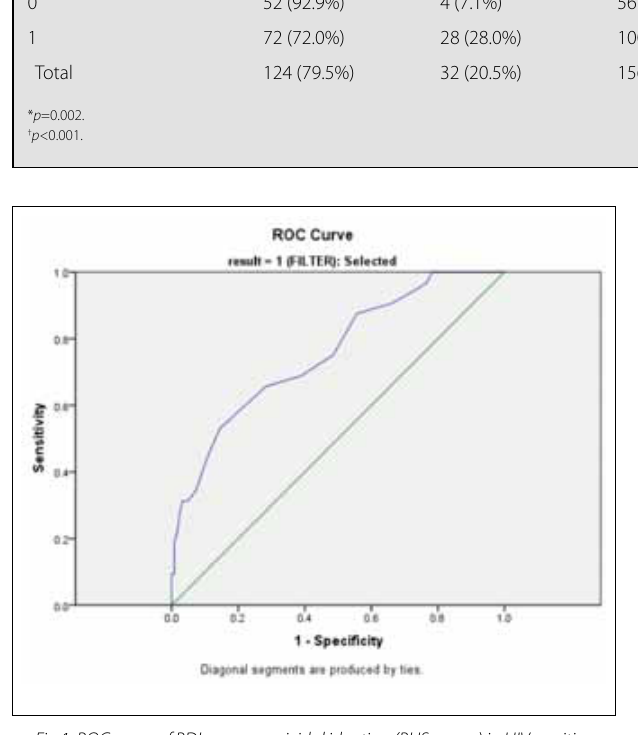
Fig. 1 indicates the ROC curve of the BDI scores used to